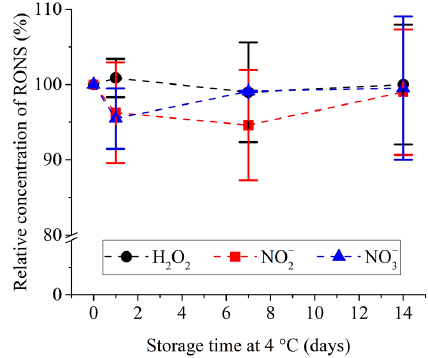
Figure 3. Relative concentration of H 2 O 2 , NO 2– and NO 3– in pPBS treated with NTP setup 2 at +11 kV during 20 min. and stored afterwards at +4 °C for up to 14 days. The reference (100%) is the concentration measured after plasma treatment at day 0. Data are presented as mean values ± SD of independent